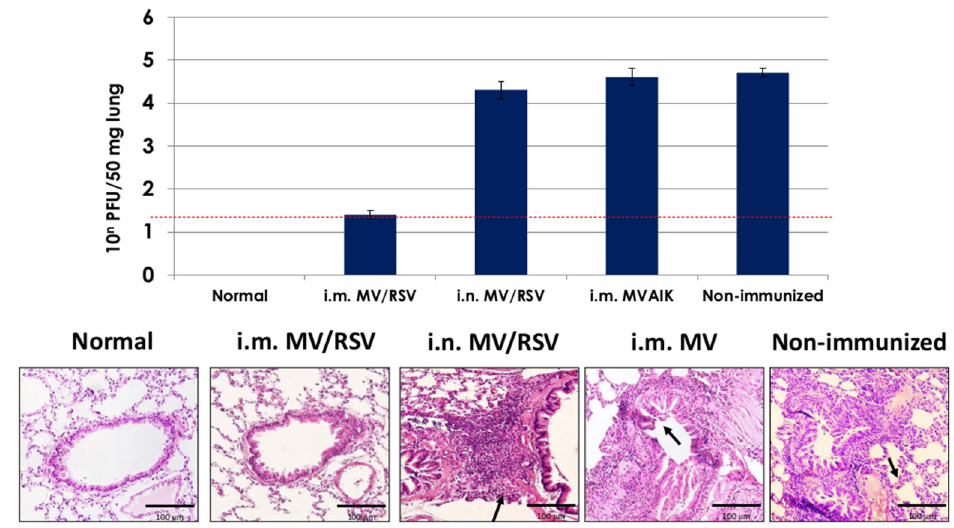
Figure 7. Recovery of the infectious virus in the lung tissue homogenates and the pathological findings of lung tissues. Infectivity is expressed per 50 mg lung tissue with error bars. Formalin-embedded lung tissues were sectioned and stained with HE. Arrows show the pathological findings and scale bars represent 100 μ m. The red dotted line indicates detection limit of recovery of infectious RSV.